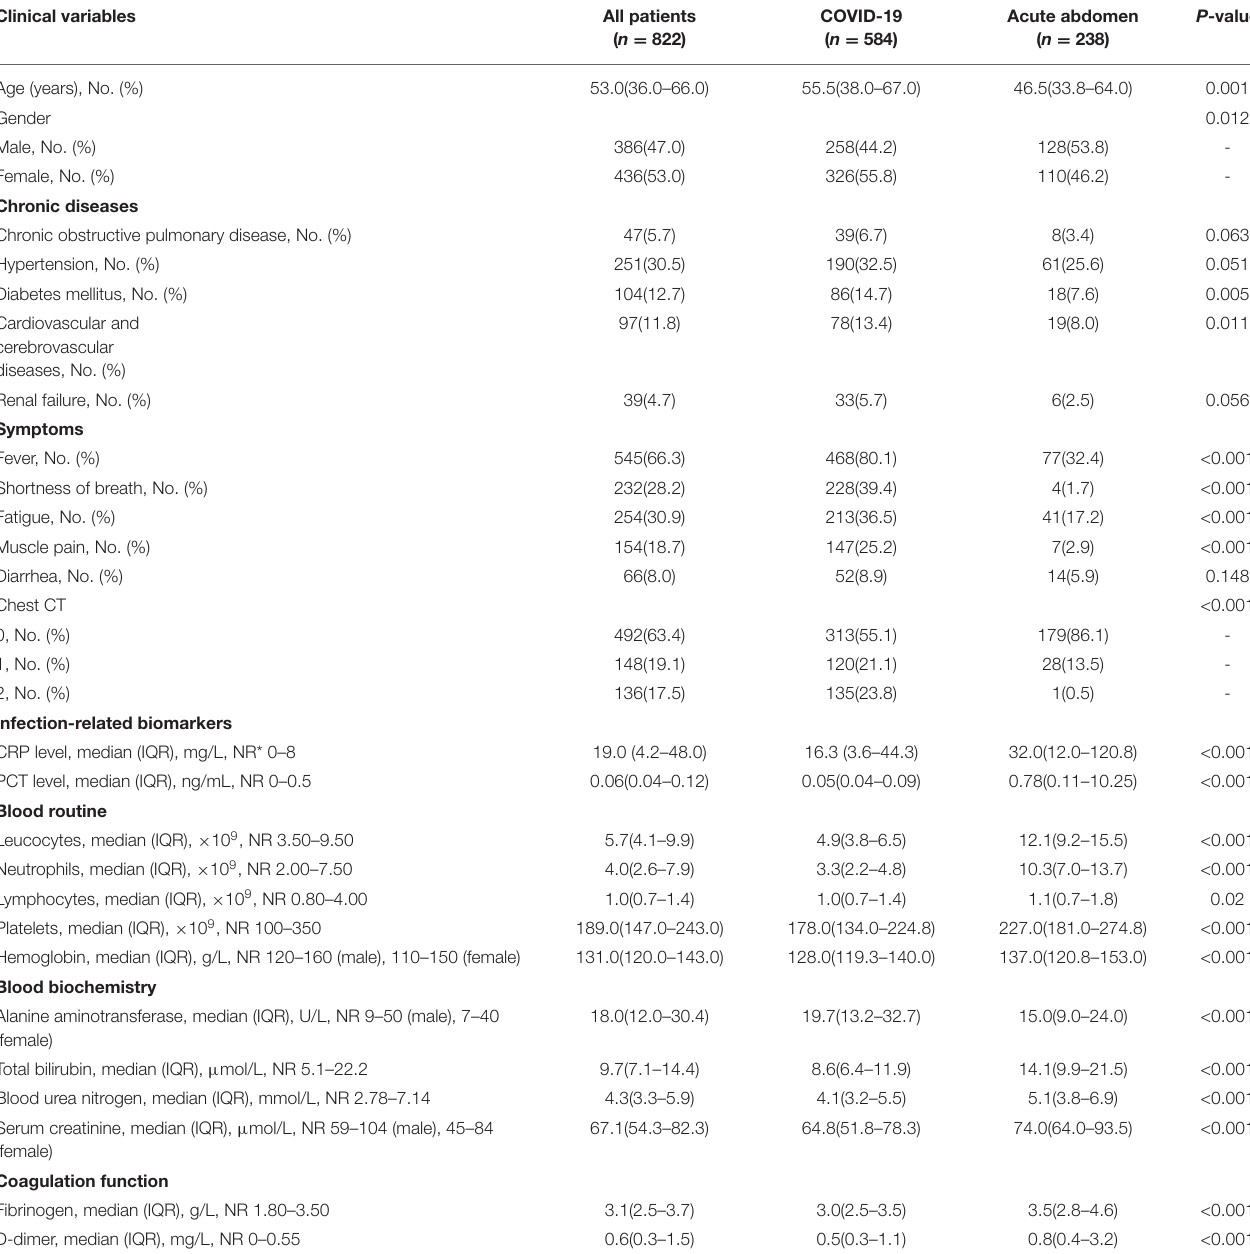
TABLE 1 | Demographic, clinical, imaging, and laboratory characteristics of patients on admition or first to emergency. Clinical